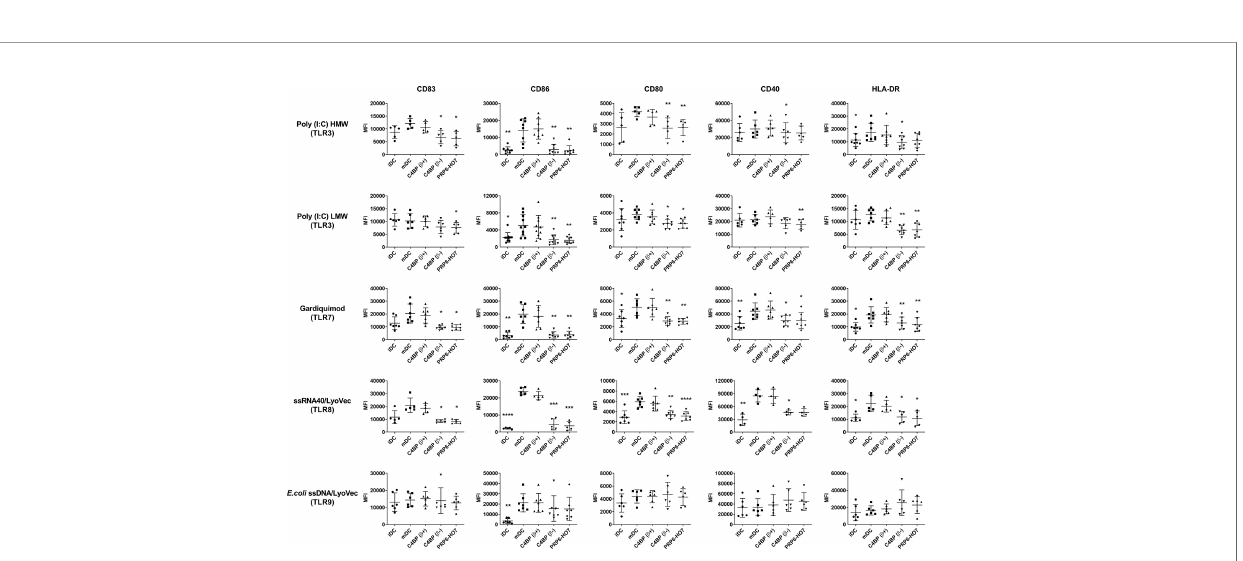
FIGURE 6 | PRP6-HO7 prevents pro-in fl ammatory intracellular (endosomal) TLR activation of Mo-DCs. Human Mo-DCs were incubated throughout their differentiation process with C4BP( b +), C4BP( b -) (both at 12 nM) and PRP6-HO7 (32 nM). DC maturation was achieved by TLR agonist treatment: Poly I:C HMW (TLR3), Poly I:C LMW (TLR3), Gardiquimod (TLR7), ssRNA40/LyoVec (TLR8), E.coli ssDNA/LyoVec (TLR9). Cells were then collected, washed, and analyzed by fl ow cytometry for cell surface expression of CD83, CD86, CD80, CD40 and HLA-DR. MFI, median fl uorescence intensity for the different surface markers. iDC, untreated, immature DCs; mDC, untreated, TLR-matured DCs. The results shown are the mean ± SD from 4-10 independent donors (*, p < 0.05; **, p < 0.01; ***, p < 0.001; ****, p < 0.0001 compared with